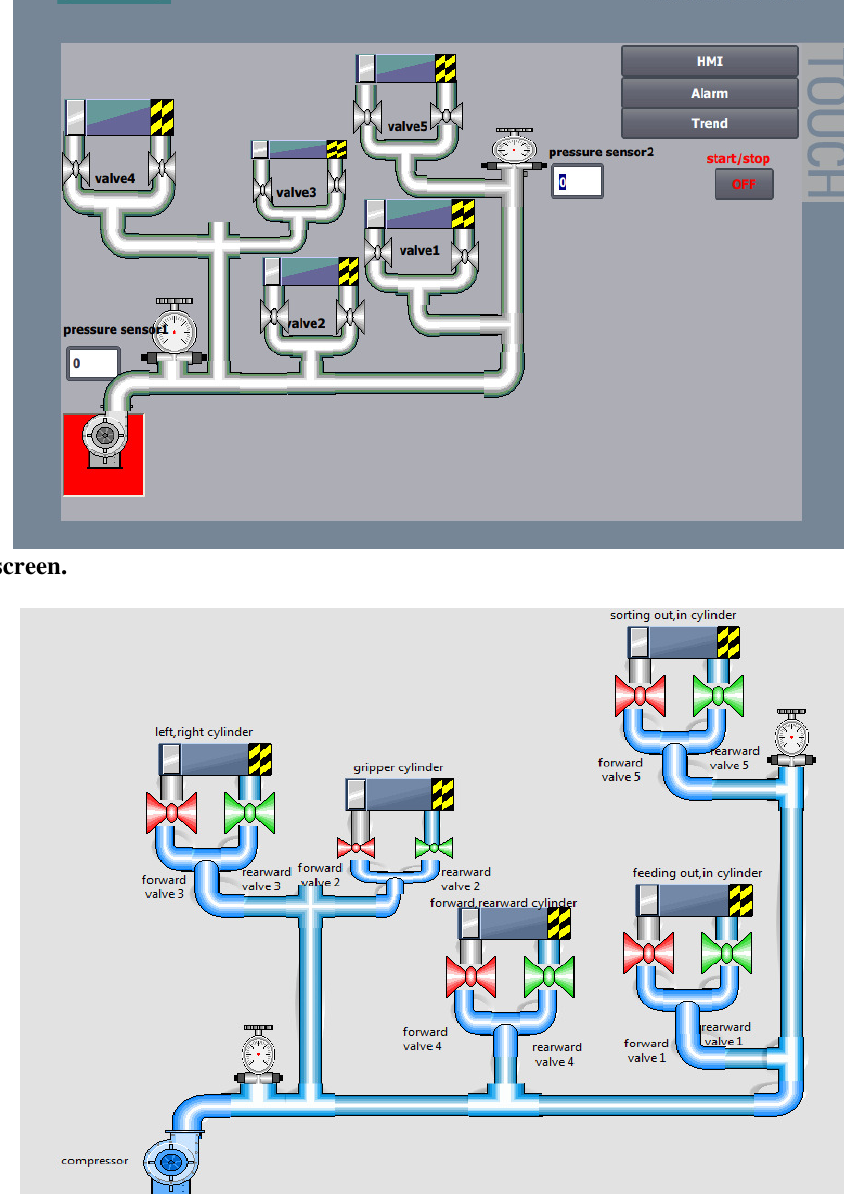
Fig. 17. Two HMI result robotic arm stop and sorting conveyer start . 4- If the work piece was metallic, the conveyer would be stopped (reset) and the sorting cylinder was on(set), as shown in figure